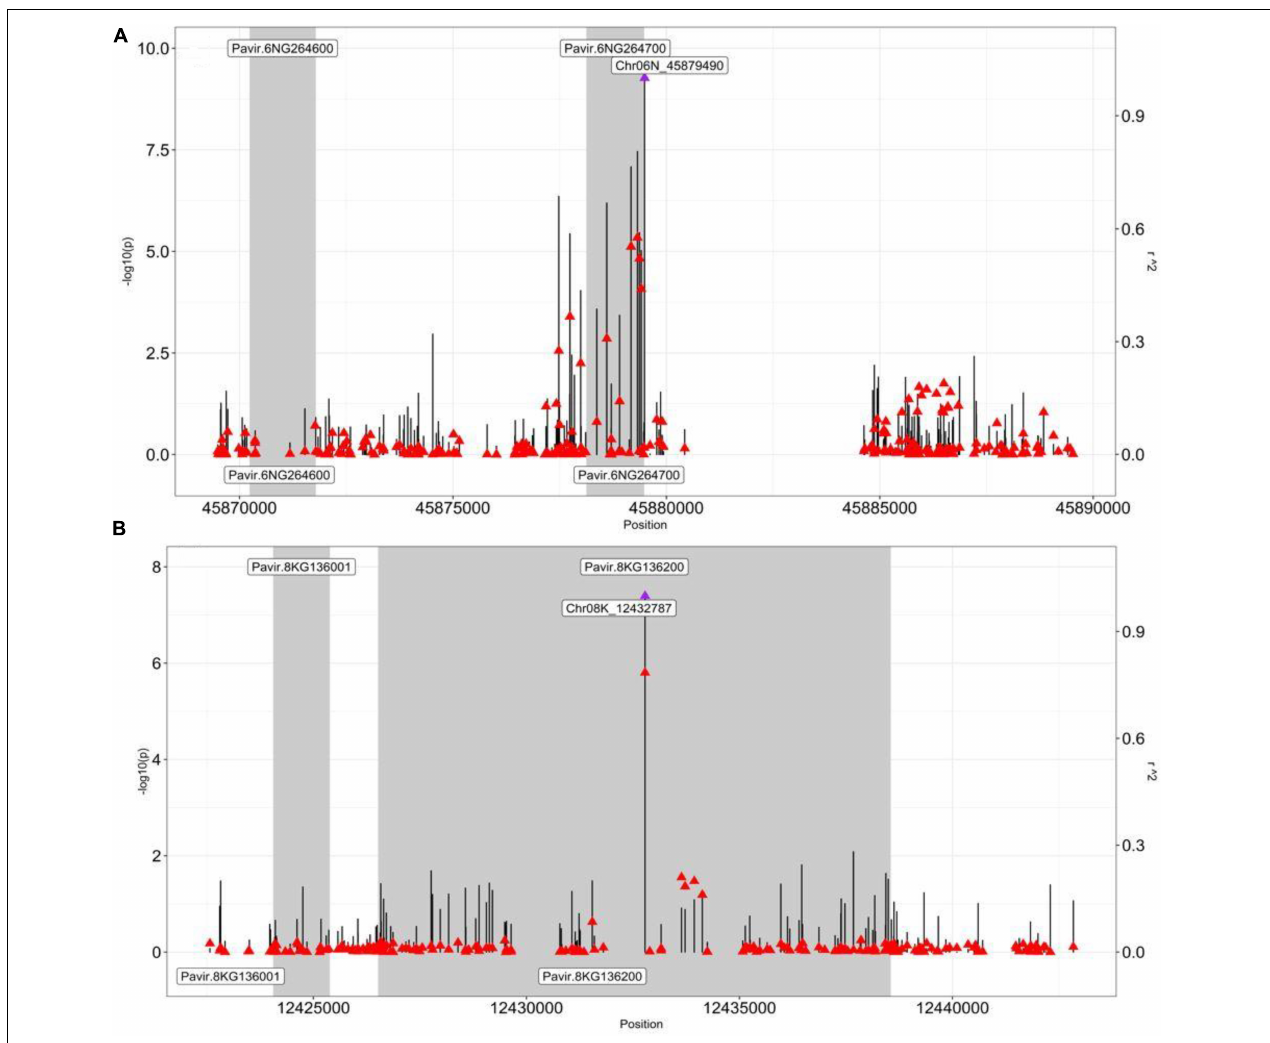
FIGURE 3 | Pairwise LD analysis between the peak SNP and the SNP underlying genes. Pairwise LD estimates ( r2 ) of the GWAS peak SNP with SNPs spanning a 20-kb ( ± 10 kb) interval from the GWAS peak SNP. A scatterplot of the association results and LD estimates with the GWAS peak SNP (A) Chr06N_45879490 (dry biomass moderate N) and (B) Chr08K_12432787 (NUE), with SNPs spanning a 20-kb interval from their respective positions (bp). The negative log10-transformed p -values (left, y-axis) and r 2 (right, y-axis) from the GWAS analysis are plotted against the genomic physical position. Vertical lines are the negative –log10 transformed p -values for individual SNPs from the GWAS results. Red triangles are pairwise LD r 2 estimates of SNPs with the GWAS peak SNP (a purple triangle). Shaded bars designate genes. Gene Pavir.6NG264700 in panel (A) is caffeoyl-CoA O-methyltransferase ( CCoAOMT ), and gene Pavir.8KG136200 in panel (B) is alfin-like 6 ( AL6